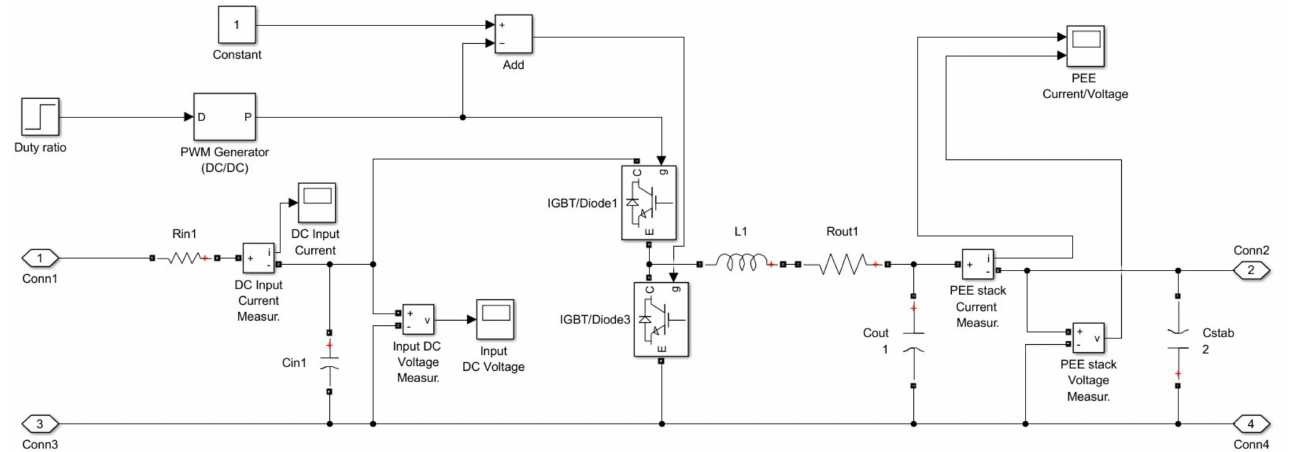
Figure 2. Layout of the DC/DC Buck Converter in the Simulink ®